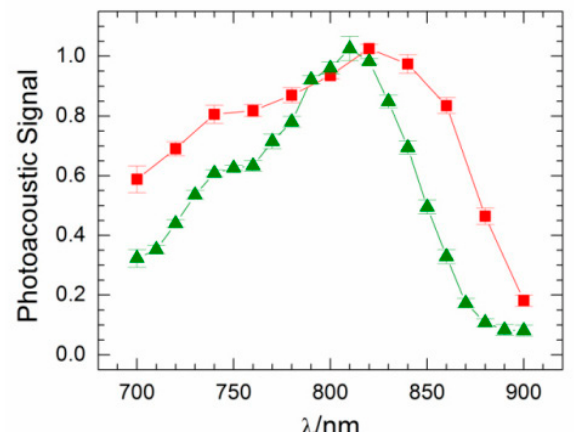
Figure 6. The optoacoustic spectra of free ICG in 3 μ L/mL saline ( ■ ) and in 3 μ L/mL plasma ( ▲ ). Eight trials were done, and the average of data for the various trials was plotted. Figure from [75] reproduced with permission from the publisher.